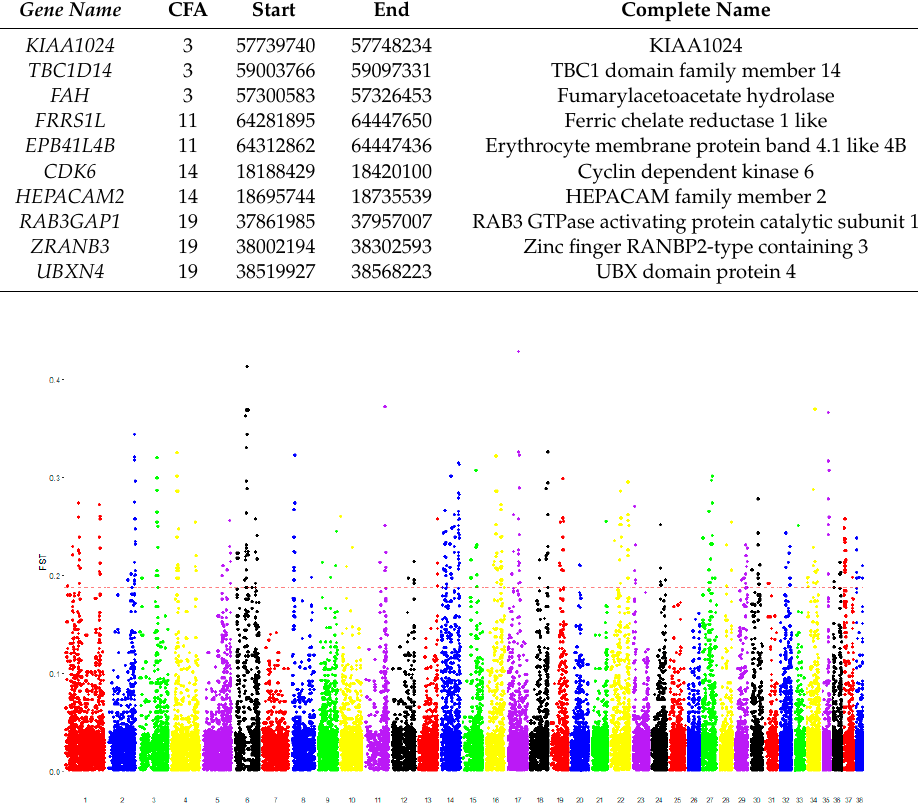
Figure 1. Manhattan plots of the Wright’s fixation index (F ST ) analysis comparing cases vs. controls. Each single-nucleotide polymorphism (SNP) is represented by a dot. Each chromosome is represented by a different color. The dotted red line represents the cutoff value of the top 1%, equal to 0.19. The genomic regions in which SNPs were mapped over the dotted red line were considered as significantly different between the two compared groups.